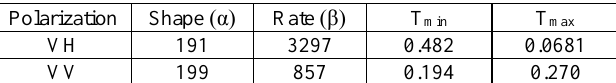
Table 2: Median parameters of the modelled gamma distribution parameters, and corresponding anomalies thresholds ( 𝛼 = 0.01 ).